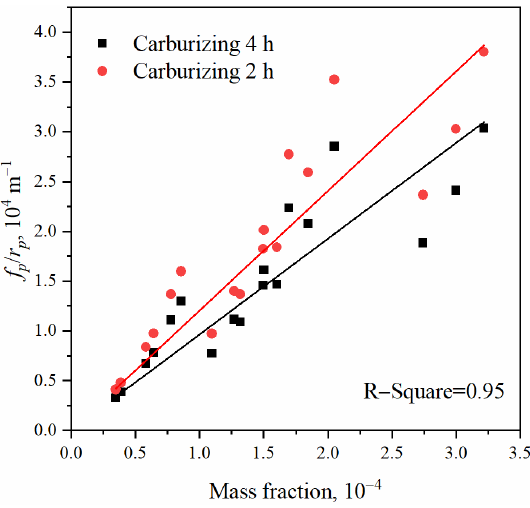
Figure 11. Relationship between the calculated pinning strength and the mass fraction of AlN pre- cipitate.